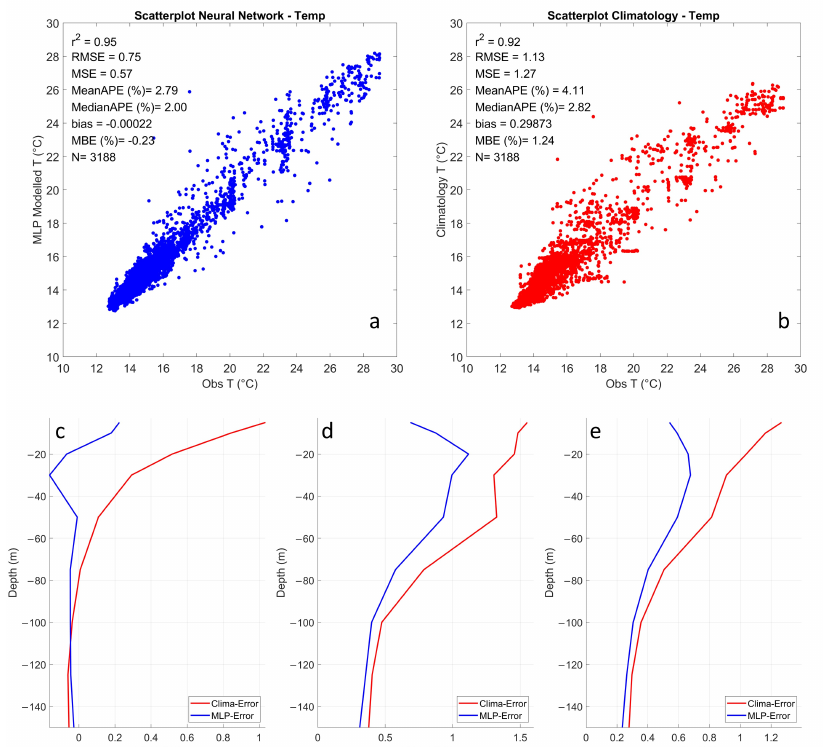
Figure 11. Results of the temperature comparison between the MLP performance (in blue) and MEDATLAS climatology (in red) on test set. In the upper left panel ( a ), a scatterplot of the observed values (on x-axis) vs. MLP predictions (on y-axis) is shown (blue dots). As a counterpart (red dots), the upper right panel ( b ) shows the scatterplot of the comparison between the observed values (on x-axis) and climatology (on y-axis). The relative statistics is given in each panel, with N as the number of available data for the matchups database. Bottom panels show the MBE ( c ), RMSE ( d ) and the MAE ( e ) in function of depth for the MLP (blue line) and climatology (red line) comparison. For temperature the reference MEDATLAS climatology is the monthly mean